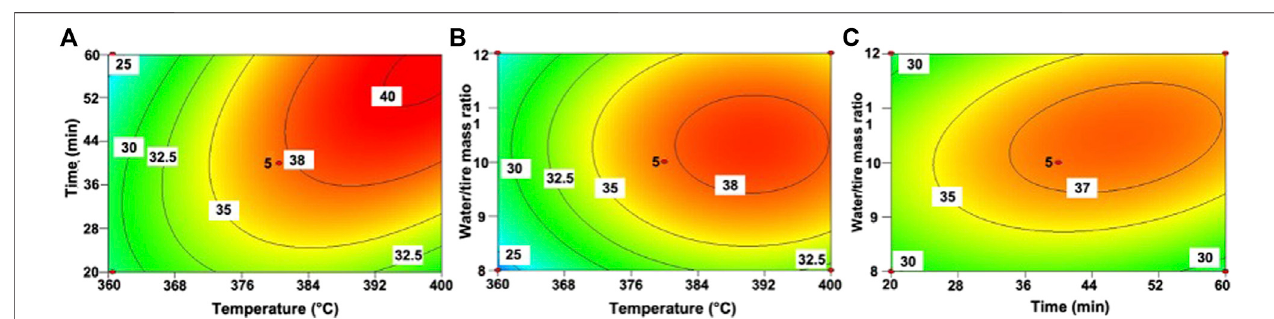
FIGURE2| Thecontourplotsforliquefactionrateat (A) constantsolidsconcentration(10 wt.%), (B) constantreactiontime(40 min)and (C) constanttemperature (380 ° C).